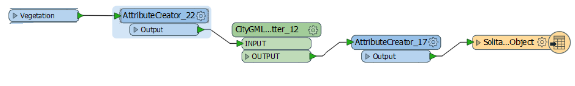
Figure 12: Transformation of Vegetation